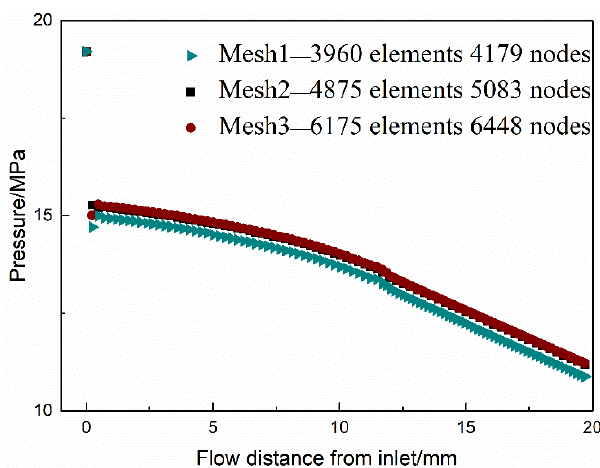
Figure 2. The simulated pressure profiles along the die wall for three mesh patterns.